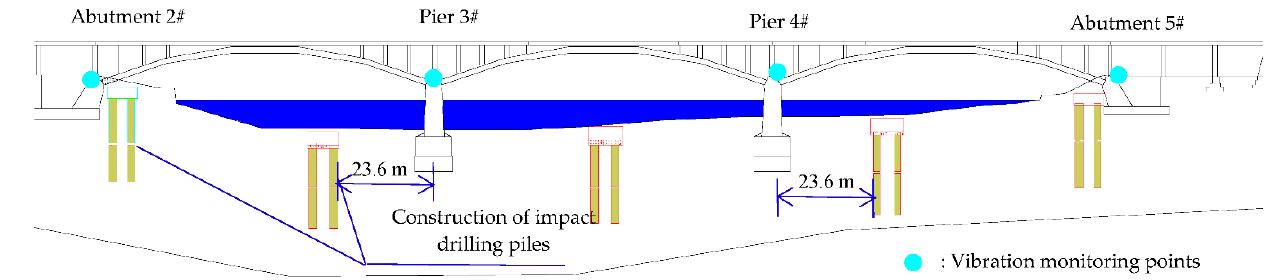
Figure 4. Front-view illustration of the vibration monitoring points.